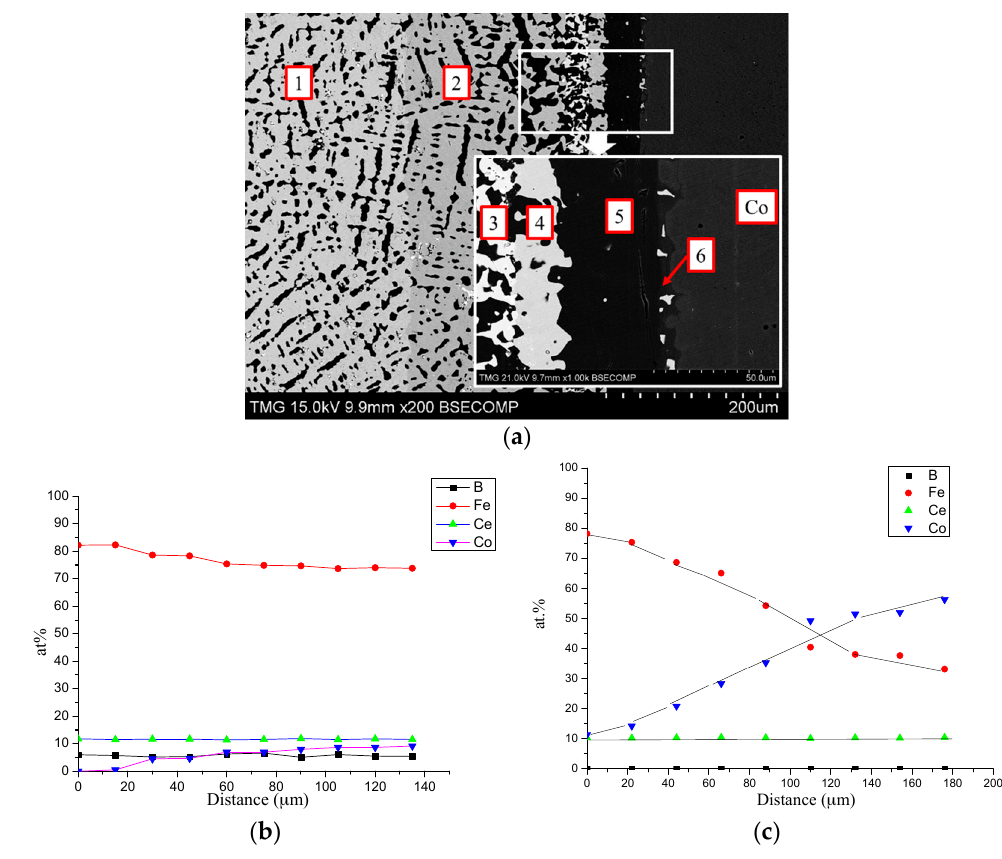
Figure 5. ( a ) BSE image of DC1; ( b ) WDS compositional profile of Ce 2 (Fe, Co) 14 B in layer 1; ( c ) WDS compositional profile of Ce 2 (Fe, Co) 17 in layer 2.